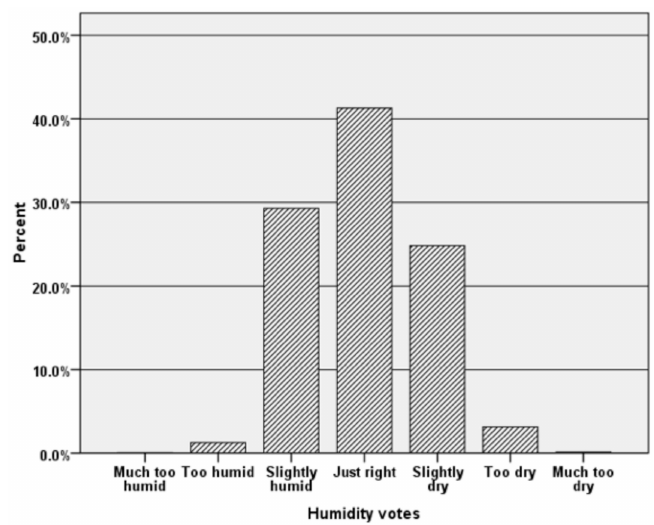
Figure 8. Students’ response to the air humidity.